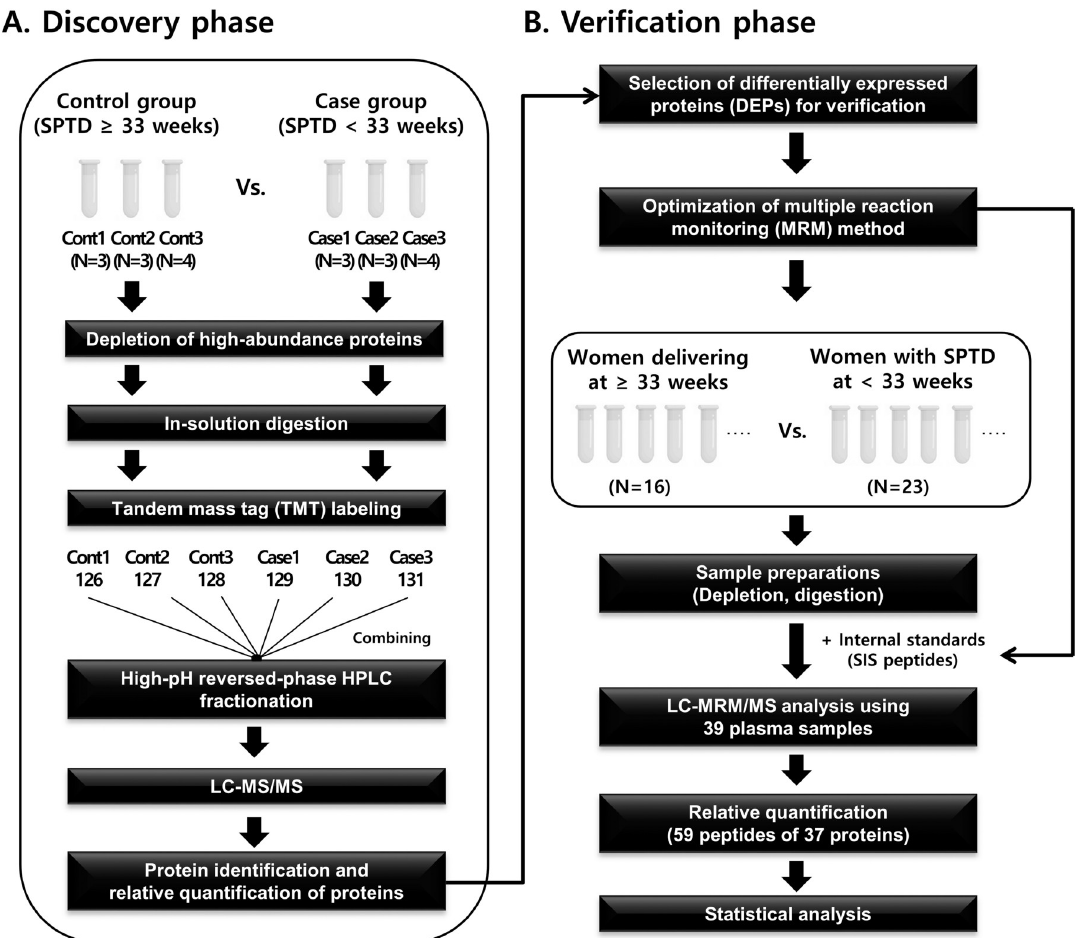
Fig 1. Schematic workflow of the discovery (TMT labeling-based quantification) and verification (LC-MRM MS) experiments. SPTD, spontaneous preterm delivery; HPLC, high-performance liquid chromatography; LC-MS/MS, liquid chromatography-tandem mass spectrometry; SIS, stable isotope-labeled